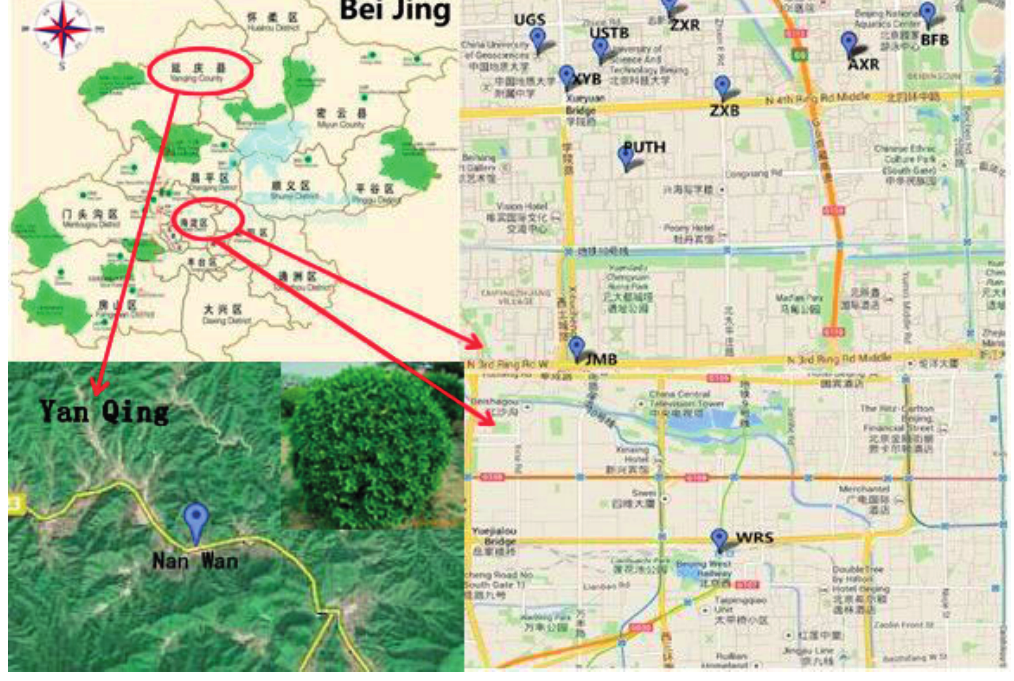
Figure 1. Locations of